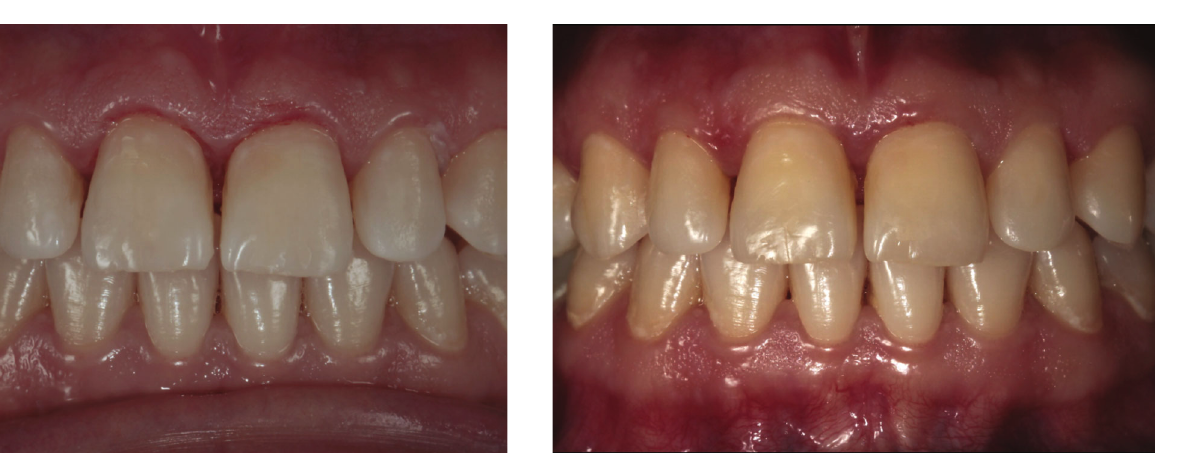
Figure 4: Final result just after rubber dam removal. Figure 5: One-year recall.